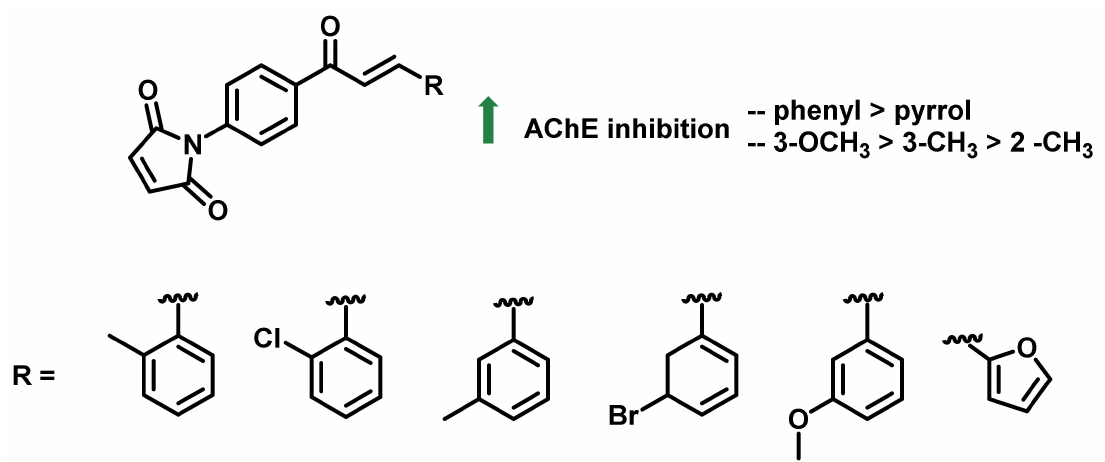
Figure 14. Chemical structures of chalcone imide